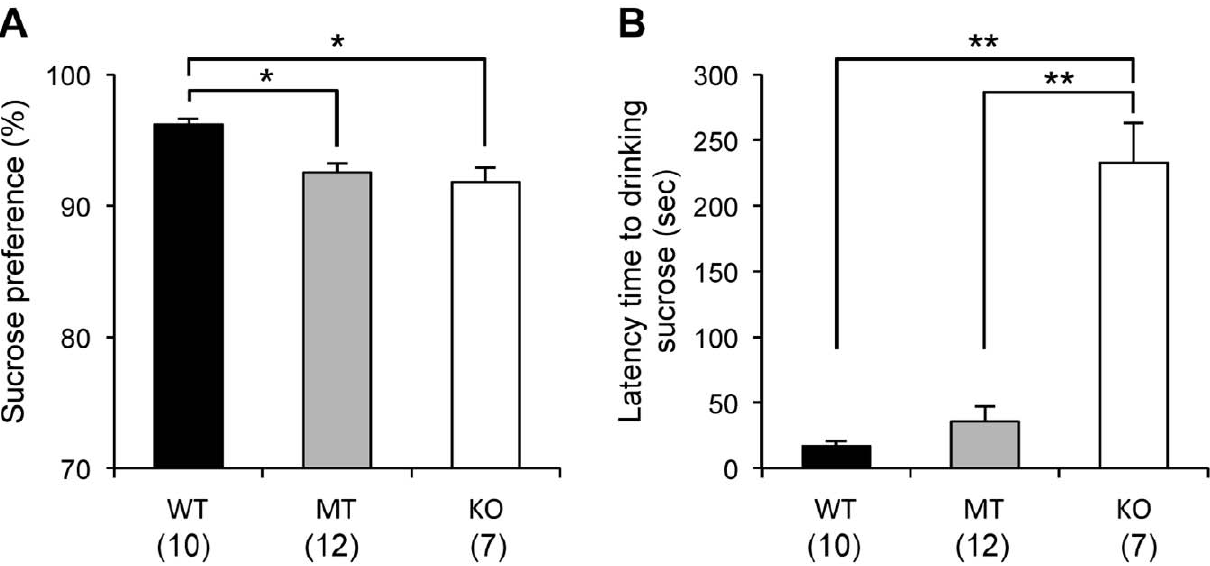
Figure 3. Sucrose preference test and the latency time to drink sucrose. (A) Usp46 MT and KO mice showed significantly lower preference for 10% sucrose than WT mice did. The ratio was calculated as the volume of sucrose consumed/total volume of fluid consumed per day. (B) On the final day of the sucrose preference test, the latency time to drinking sucrose was measured. Usp46 KO mice showed a significantly longer latency time than either MT or WT mice did. The number of mice used is shown within parentheses. One-way ANOVA with Fisher’s PLSD test; * P , 0.05, ** P , 0.01.